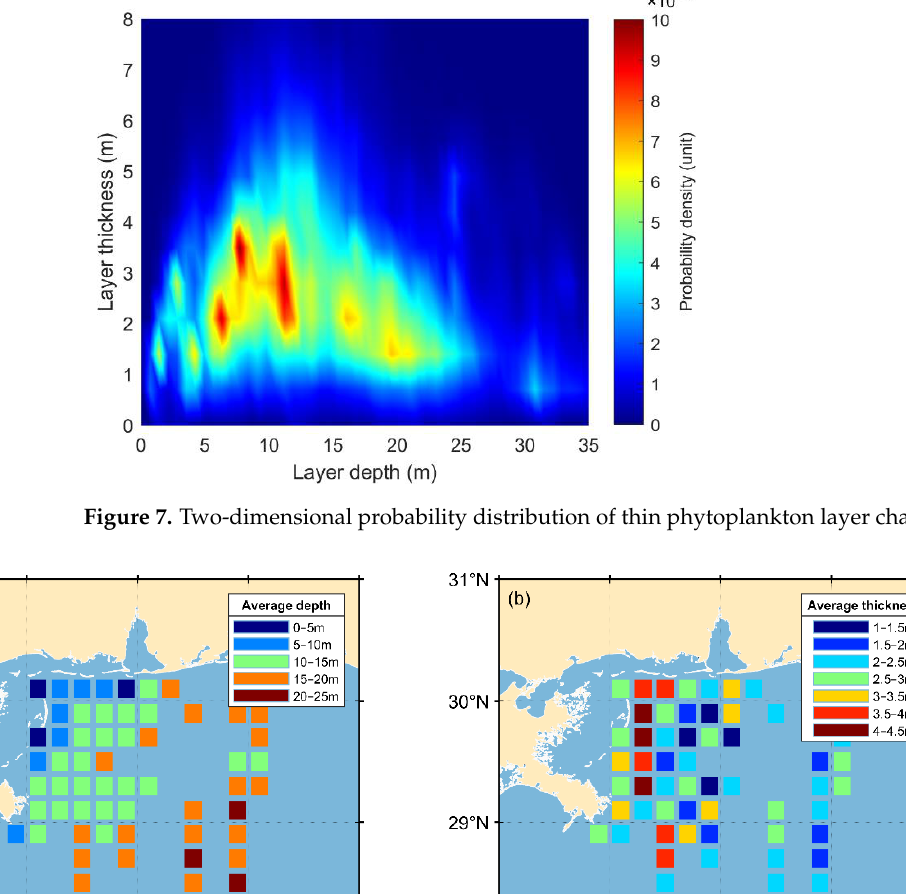
Figure 8. Map of average layer depth and thickness. ( a ) Average depth of layers in different regions; ( b ) Average thickness of layers in different regions.